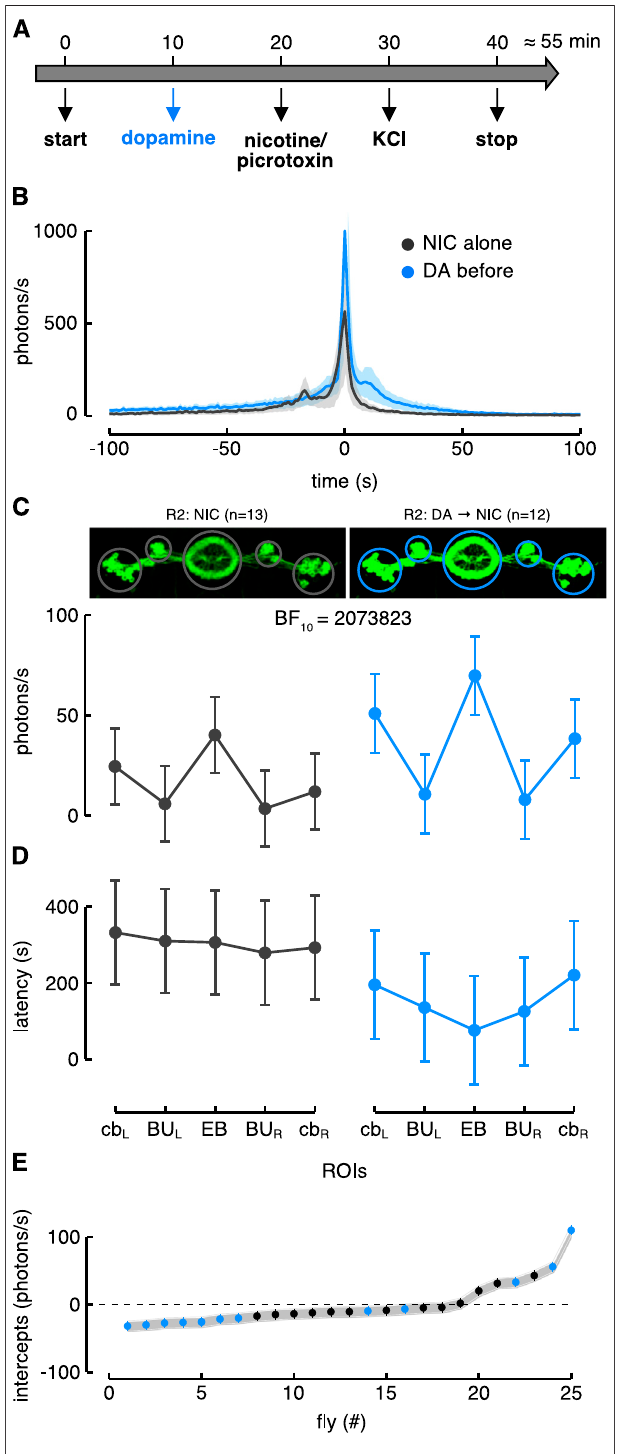
FIGURE 5 | Dopamine modulation in R2 > G5A fl ies. (A) Image of the protocolusedtomodulatetheneuronsbeforethedrugapplication(nicotineor picrotoxin). (B) Ca 2+ -response pro fi les of the R2 neurons in the EB ROI. In black is depicted the condition with the nicotine alone while in blue the condition with dopamine application before nicotine. (C) Estimated